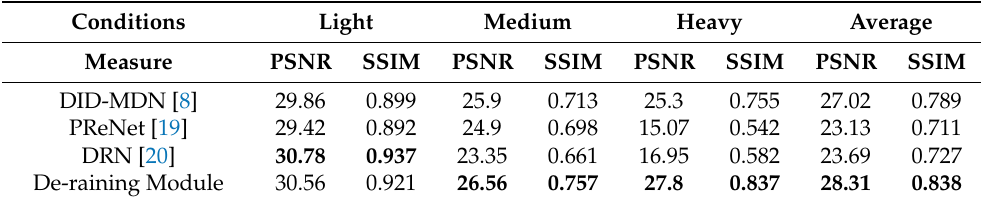
Table 1. Average PSNR and SSIM comparison on the synthetic